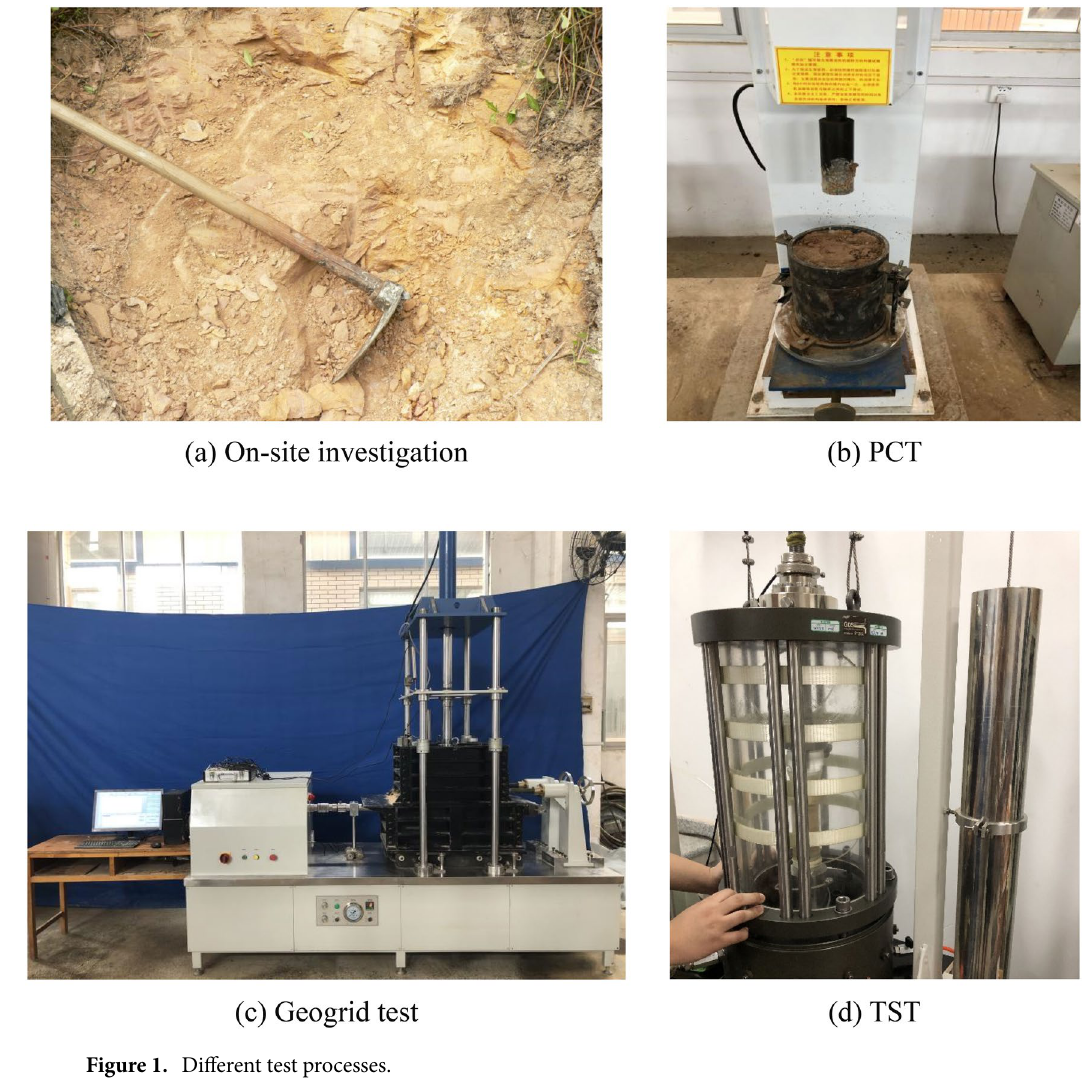
Figure 1. Different test processes.